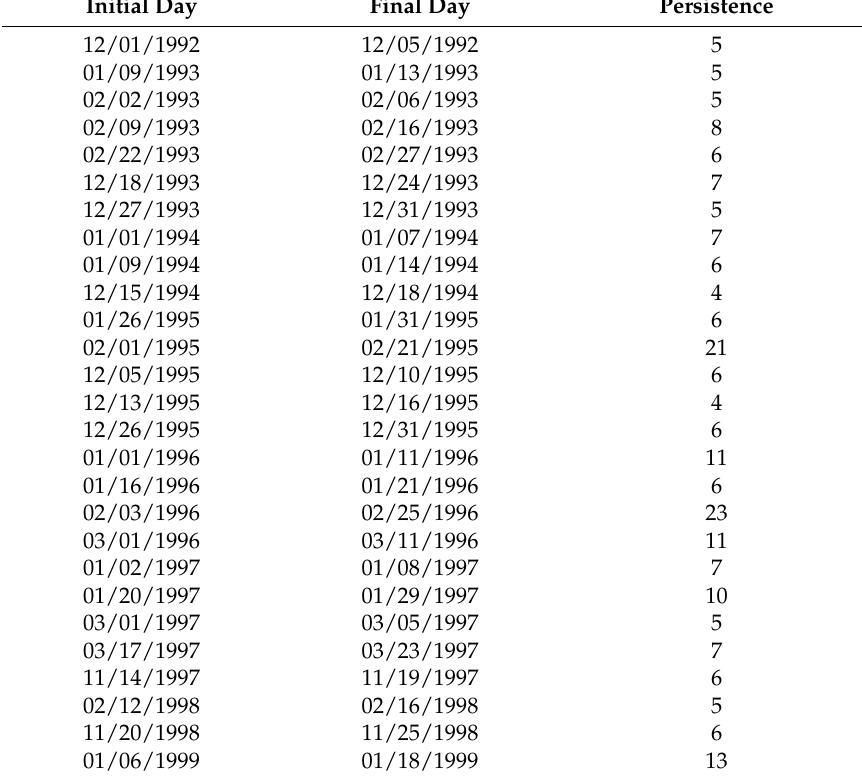
Table A1. Dates of SACZ events between 1992 and